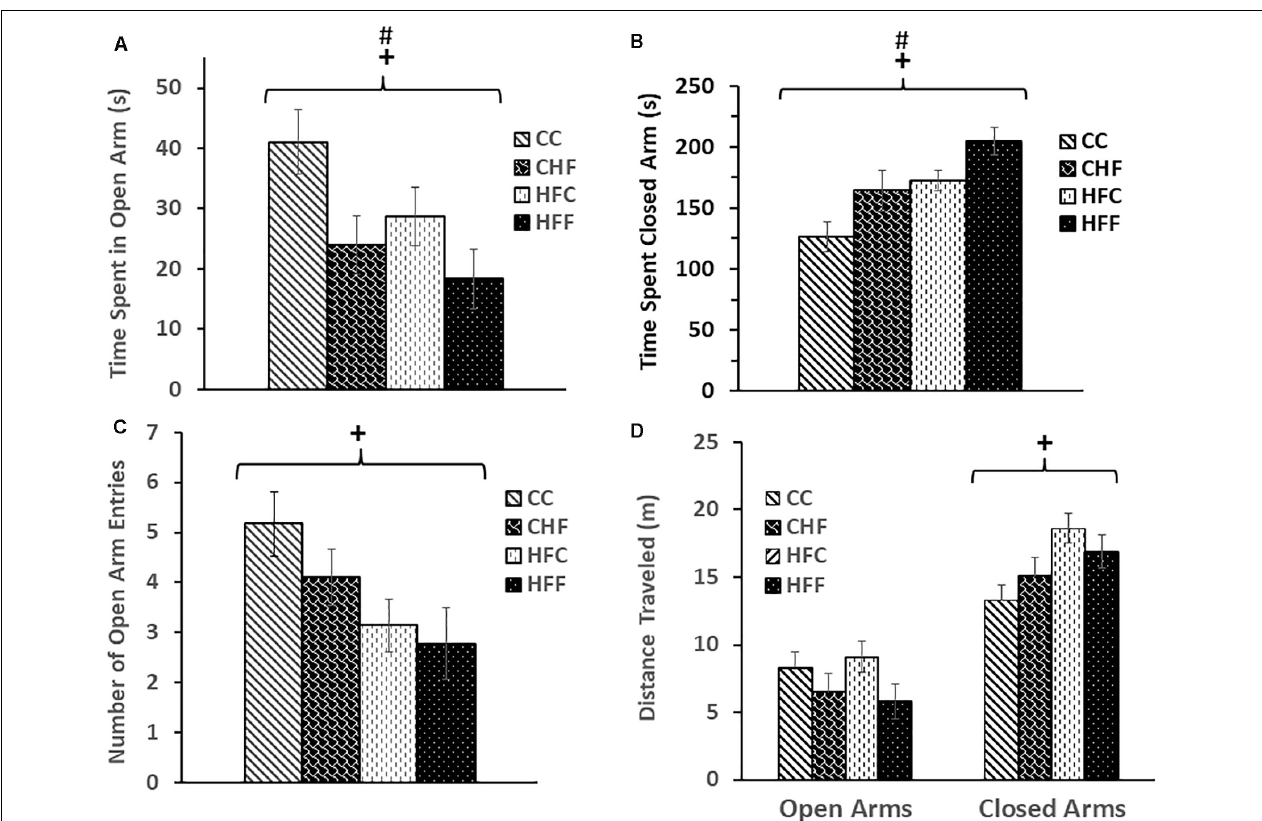
FIGURE 2 | Elevated-plus maze was used to evaluate anxiety-like behavior in adult male rat offspring: CC, CHF, HFC, or HFF. (A) Time spent in the open arms was significantly reduced in response to both the maternal (maternal diet effect: F ( 3 , 61 ) = 5.17, P = 0.034) and post-weaning high-fat diet (post-weaning diet effect: F ( 3 , 32 ) = 4.36, P = 0.049); whereas, (B) time spent in the closed arms was increased in response to both the maternal (maternal diet effect: F ( 3 , 61 ) = 6.48, P = 0.016) and post-weaning high-fat diet (post-weaning diet effect: F ( 3 , 61 ) = 5.52, P = 0.026). (C) The number of open-arm entries was significantly reduced in response to the maternal high-fat diet (maternal diet effect: F ( 3 , 61 ) = 4.19, P = 0.042) and (D) the maternal diet was associated with an increase in distance traveled by adult male offspring in the closed arms (maternal diet effect: F ( 3 , 61 ) = 5.34, P = 0.027). No significant interactions were detected using two-way ANOVA. Values are means + SEM ( n = 16 for each group). + P < 0.05 (significant maternal diet effect); # P < 0.05 (significant post-weaning diet